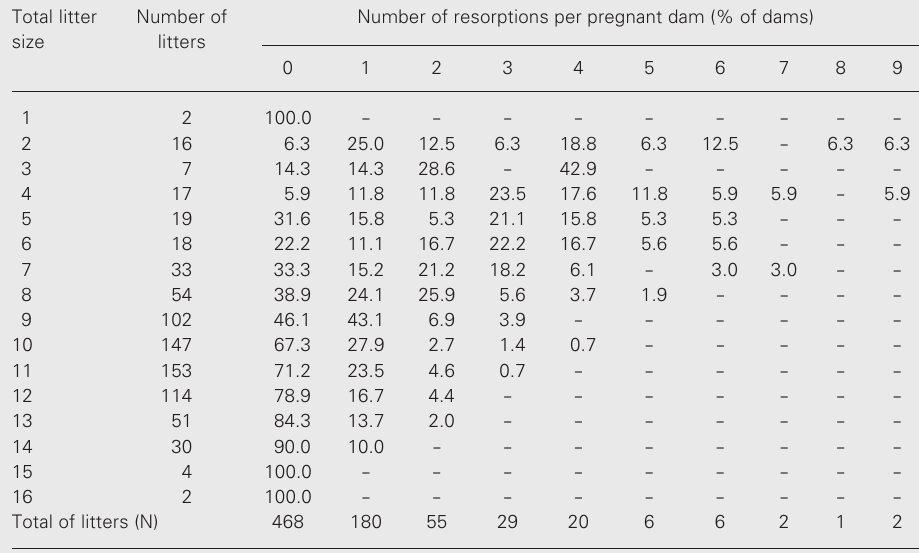
Table 2. Relationship between the number of fetuses (total litter size) and fetal resorptions per dam. Total